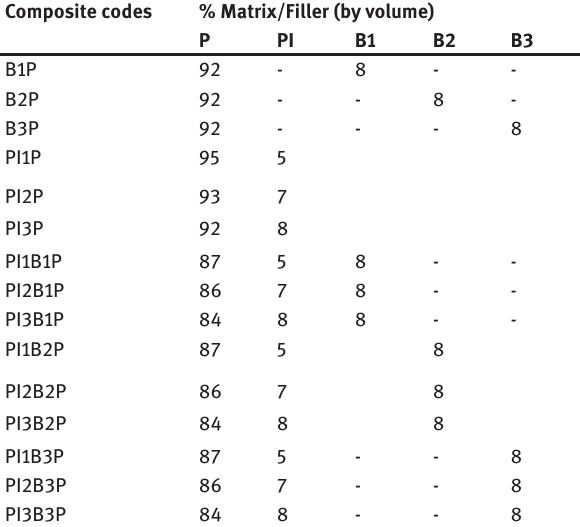
Table 1. Compositions of the composite were expressed by volume percentage.